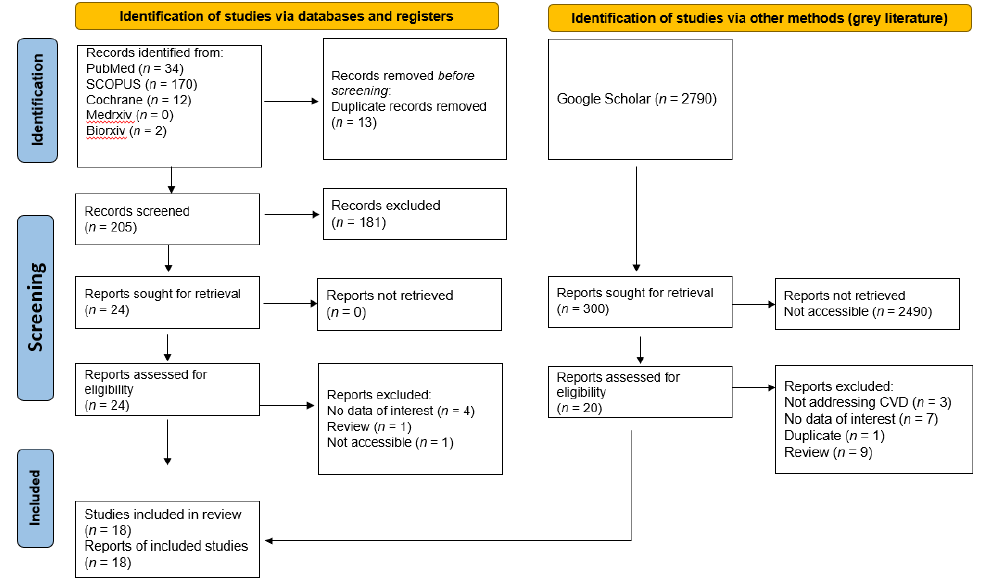
Figure 5. PRISMA Flow Diagram.